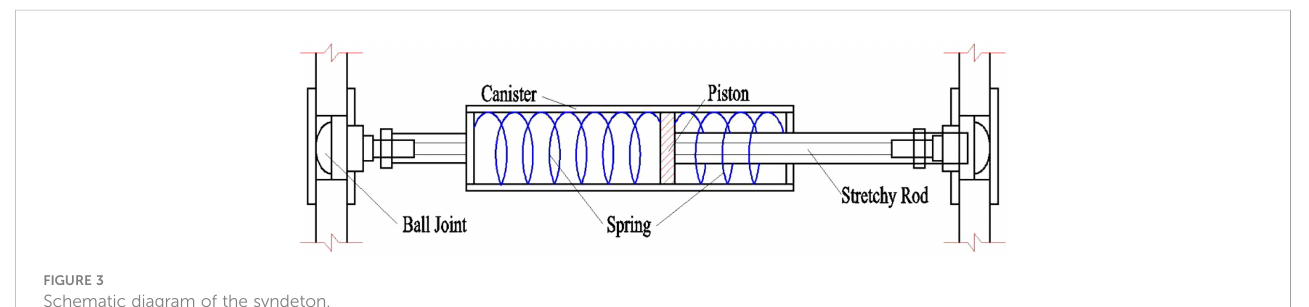
FIGURE 3 Schematic diagram of the syndeton.